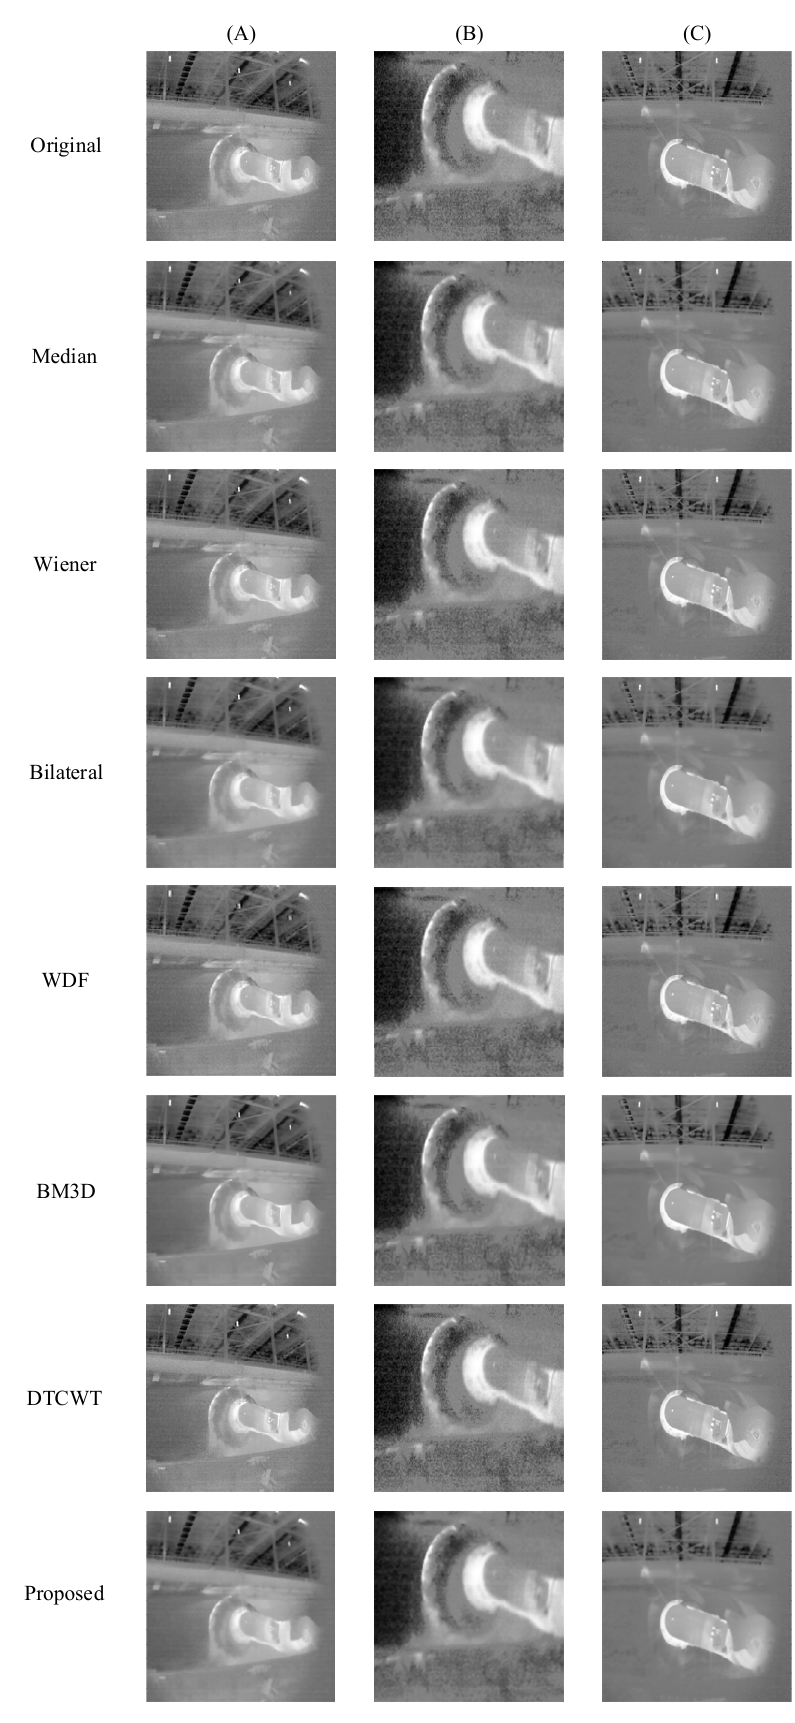
Figure 21. Original images and denoised images using different methods. ( A ) Infrared thermal image of cutting unit from the side; ( B ) Infrared thermal image of cutting unit from close distance; ( C ) Infrared thermal image of cutting unit from the